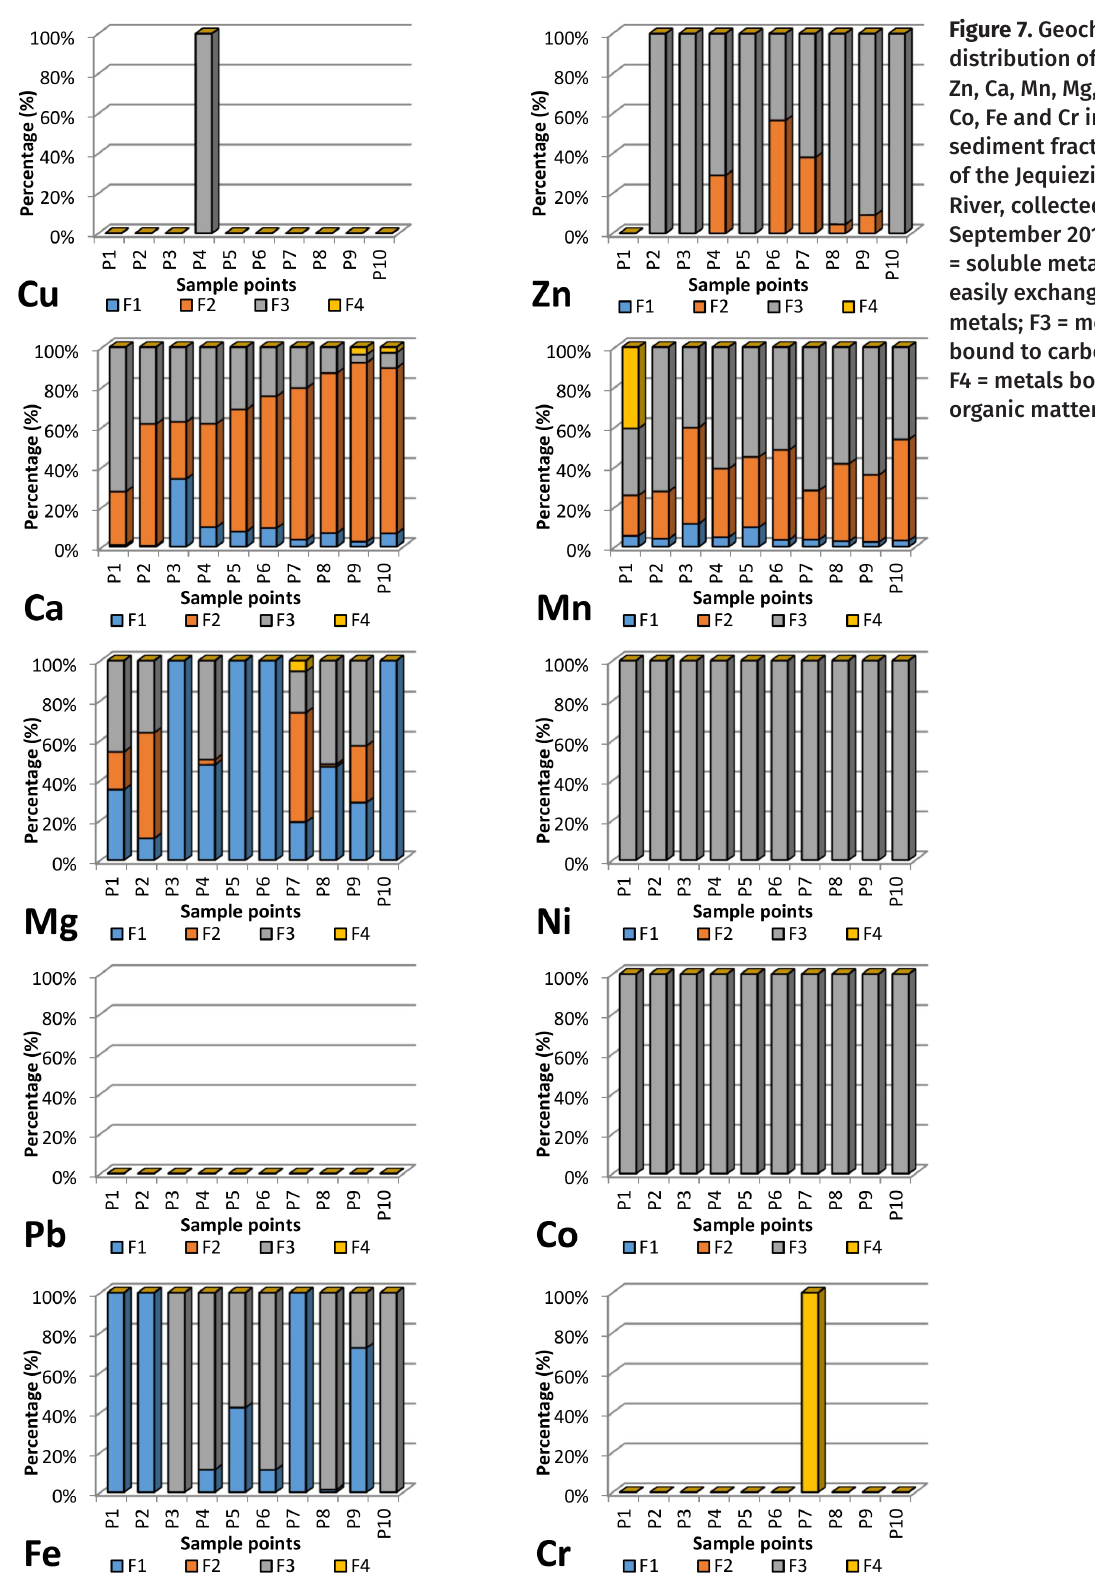
Figure 7. Geochemical distribution of Cu, Zn, Ca, Mn, Mg, Ni, Pb, Co, Fe and Cr in the sediment fractions of the Jequiezinho River, collected in September 2018. (F1 = soluble metal; F2 = easily exchangeable metals; F3 = metals bound to carbonates; F4 = metals bound to organic